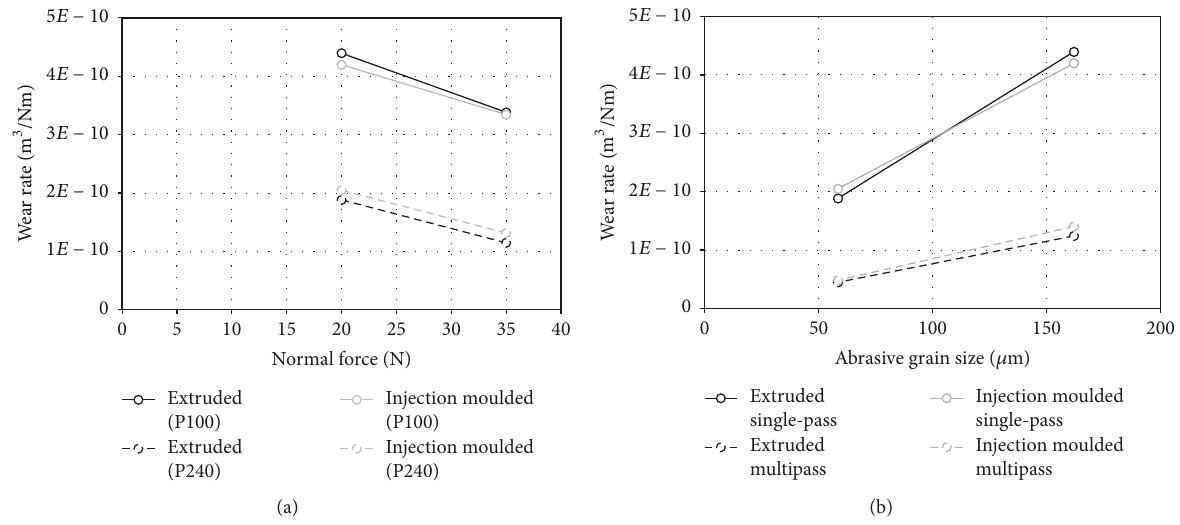
Figure 3: Specific wear rate: (a) influence of load and (b) influence of grain size.